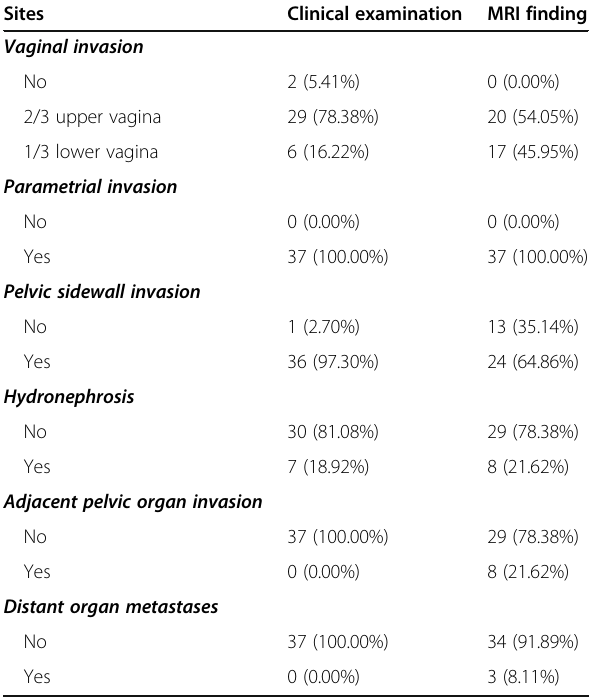
Table 3 Tumor invasions and distant metastases